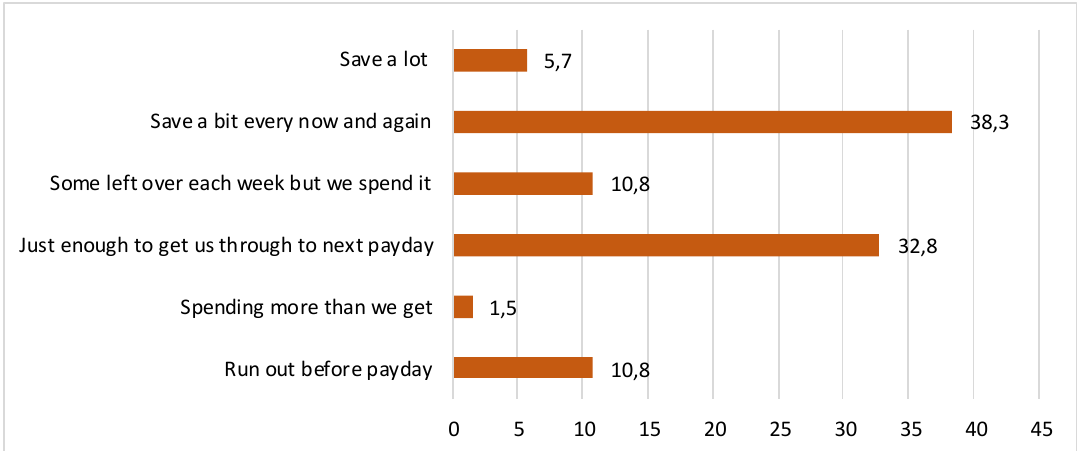
Figure 1. LSIC household self rating on financial stress (percentage).